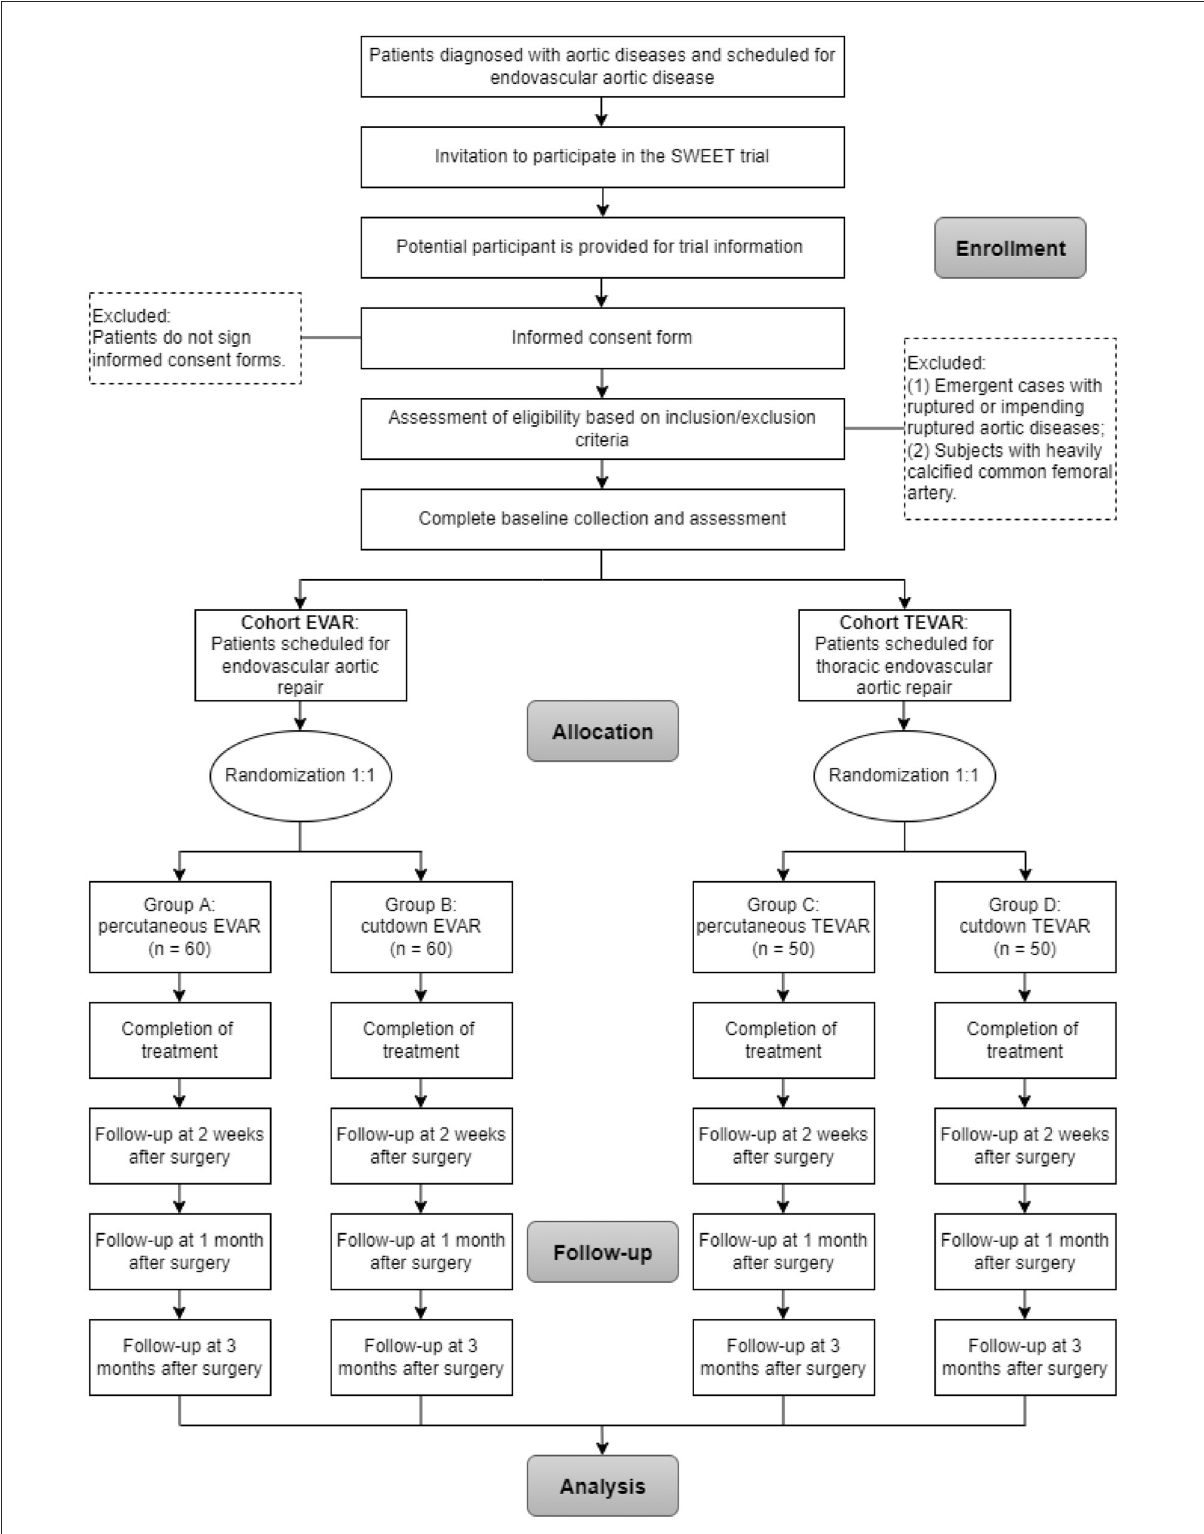
FIGURE1 Flow of participants randomly assigned to percutaneous groups and cutdown